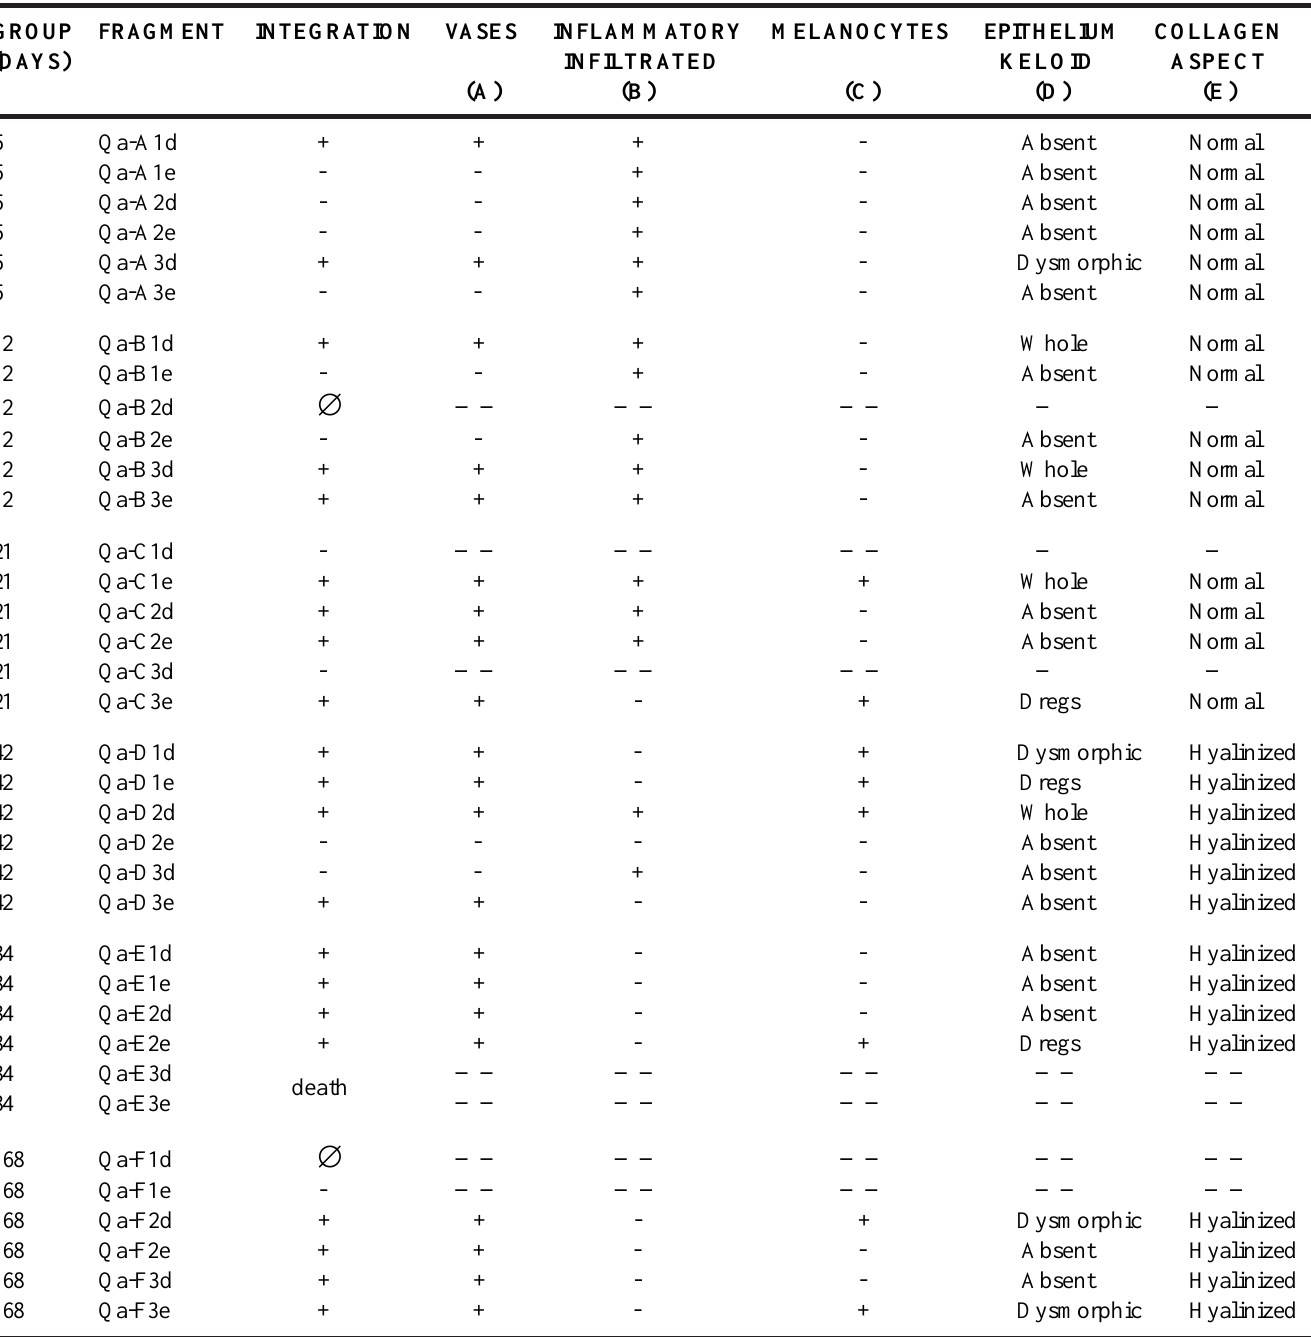
TABLE 2 - Description of histologic exams on skin